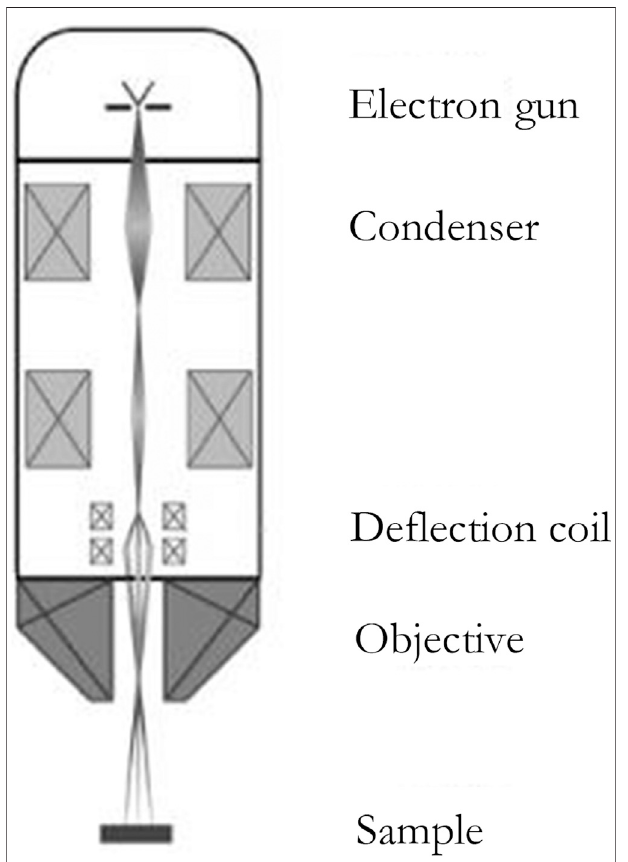
FIGURE 2 | The structure of the SEM (Muzi et al., 2013).